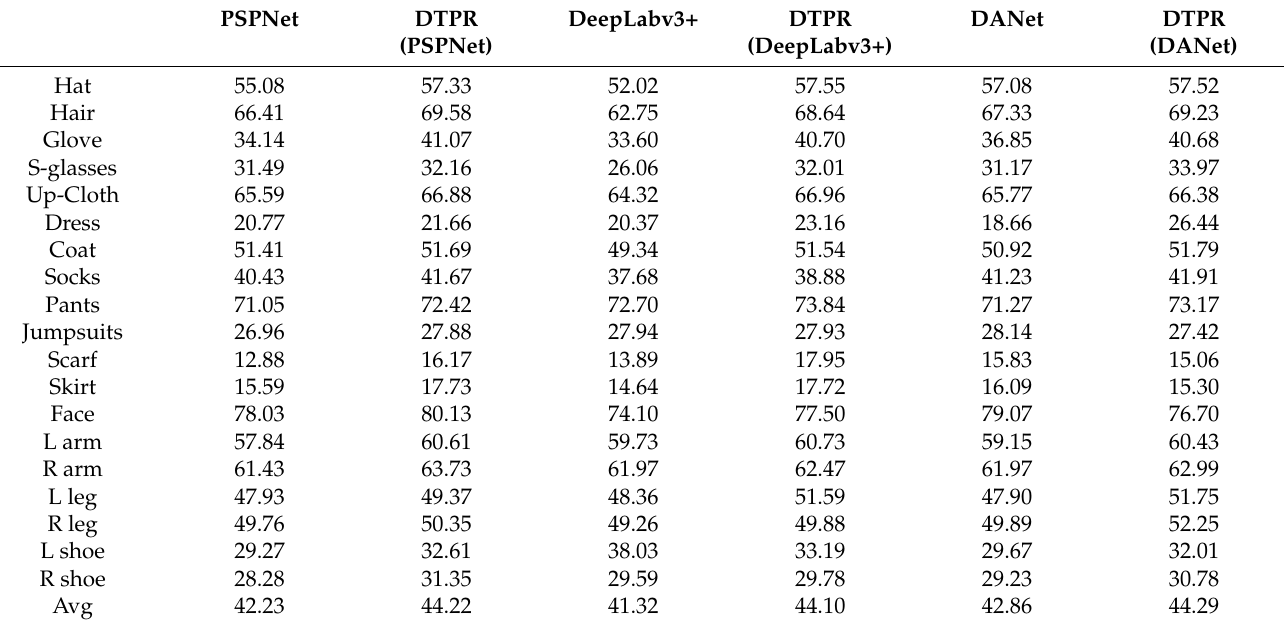
Table 6. Comparison of the SOTA model on the LIP validation